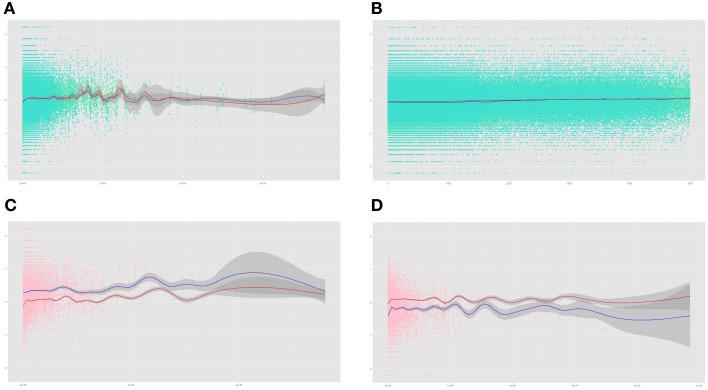
GAM regression of breast correlations as a function of absolute distance to the closest TSS. (A) GAM regression of Fisher's Z-Transformed Spearman's Correlations vs. absolute TSS distance. The blue and the red lines are the regressions of correlations in cancer and normal breast, respectively. Dark gray areas indicate 95% CI. Turquoise and light green dots are Z-correlations in cancer and normal breast, respectively. (B) Same as the previous section but focused in the 5000 bp region from the closest TSS. (C) GAM regression of DCGs with lower correlations in cancer than in normal breast. The blue and red regression lines correspond to normal and cancer breast, respectively. Pink dots indicate Spearman's correlation Z-scores in normal breast. (D) Same as in the previous section for those DCGs with higher correlations in cancer than in normal breast.